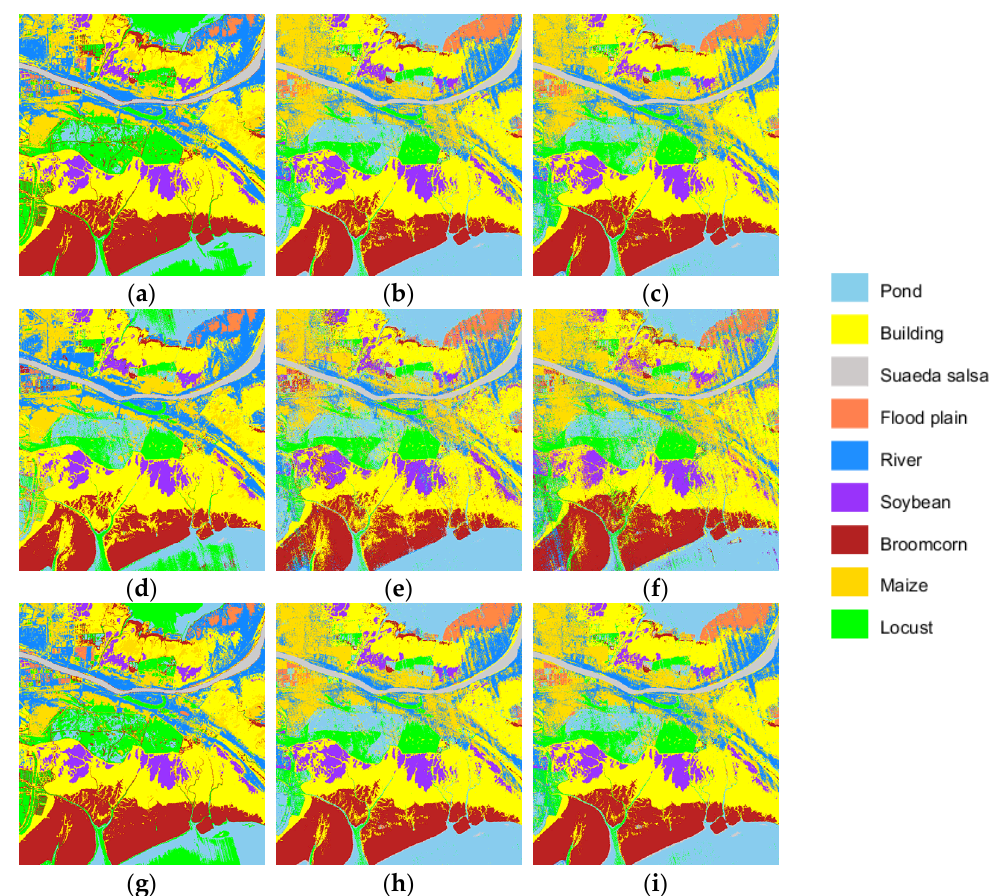
Figure 3. Classification maps of land types for different combination algorithms of Yellow River Estuary: ( a ) PCA+SVM; ( b ) LDA+SVM; ( c ) LPP+SVM; ( d ) PCA+RF; ( e ) LDA+RF; ( f ) LPP+RF; ( g ) PCA+KNN; ( h ) LDA+KNN; ( i ) LPP+KNN.